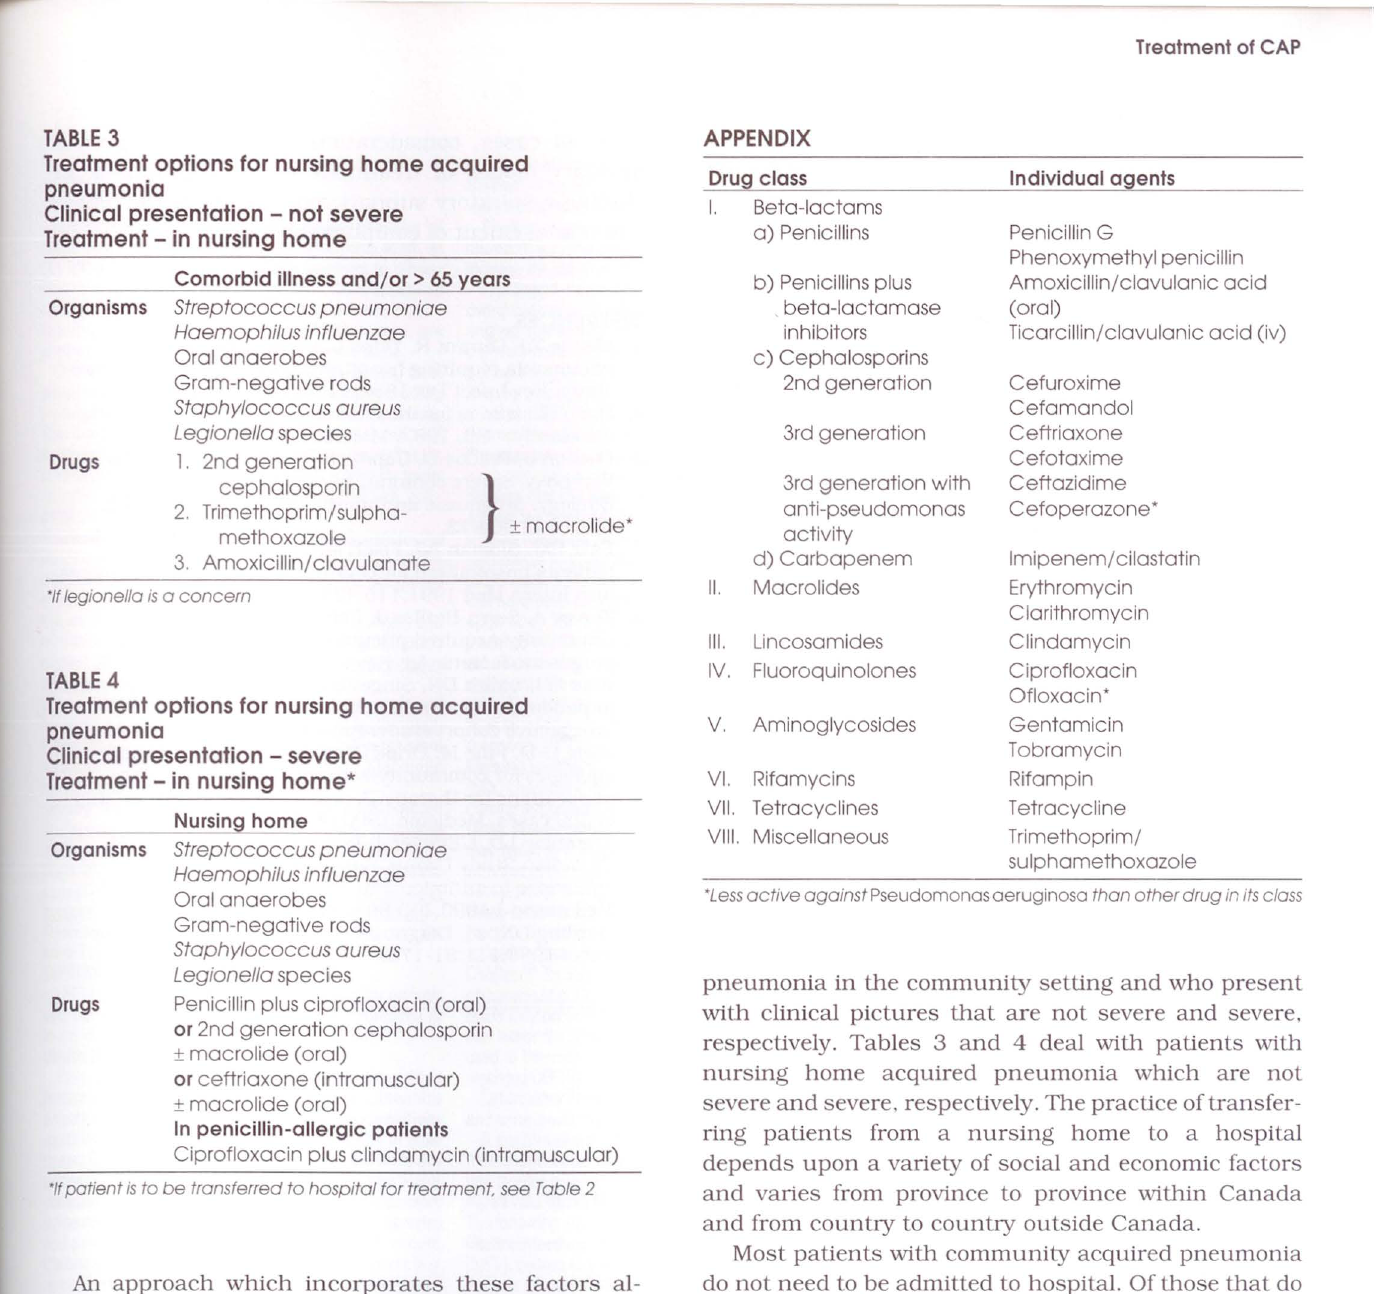
Treatment options for nursing home acquired pneumonia Clinical presentation - not severe Treatment - in nursing home